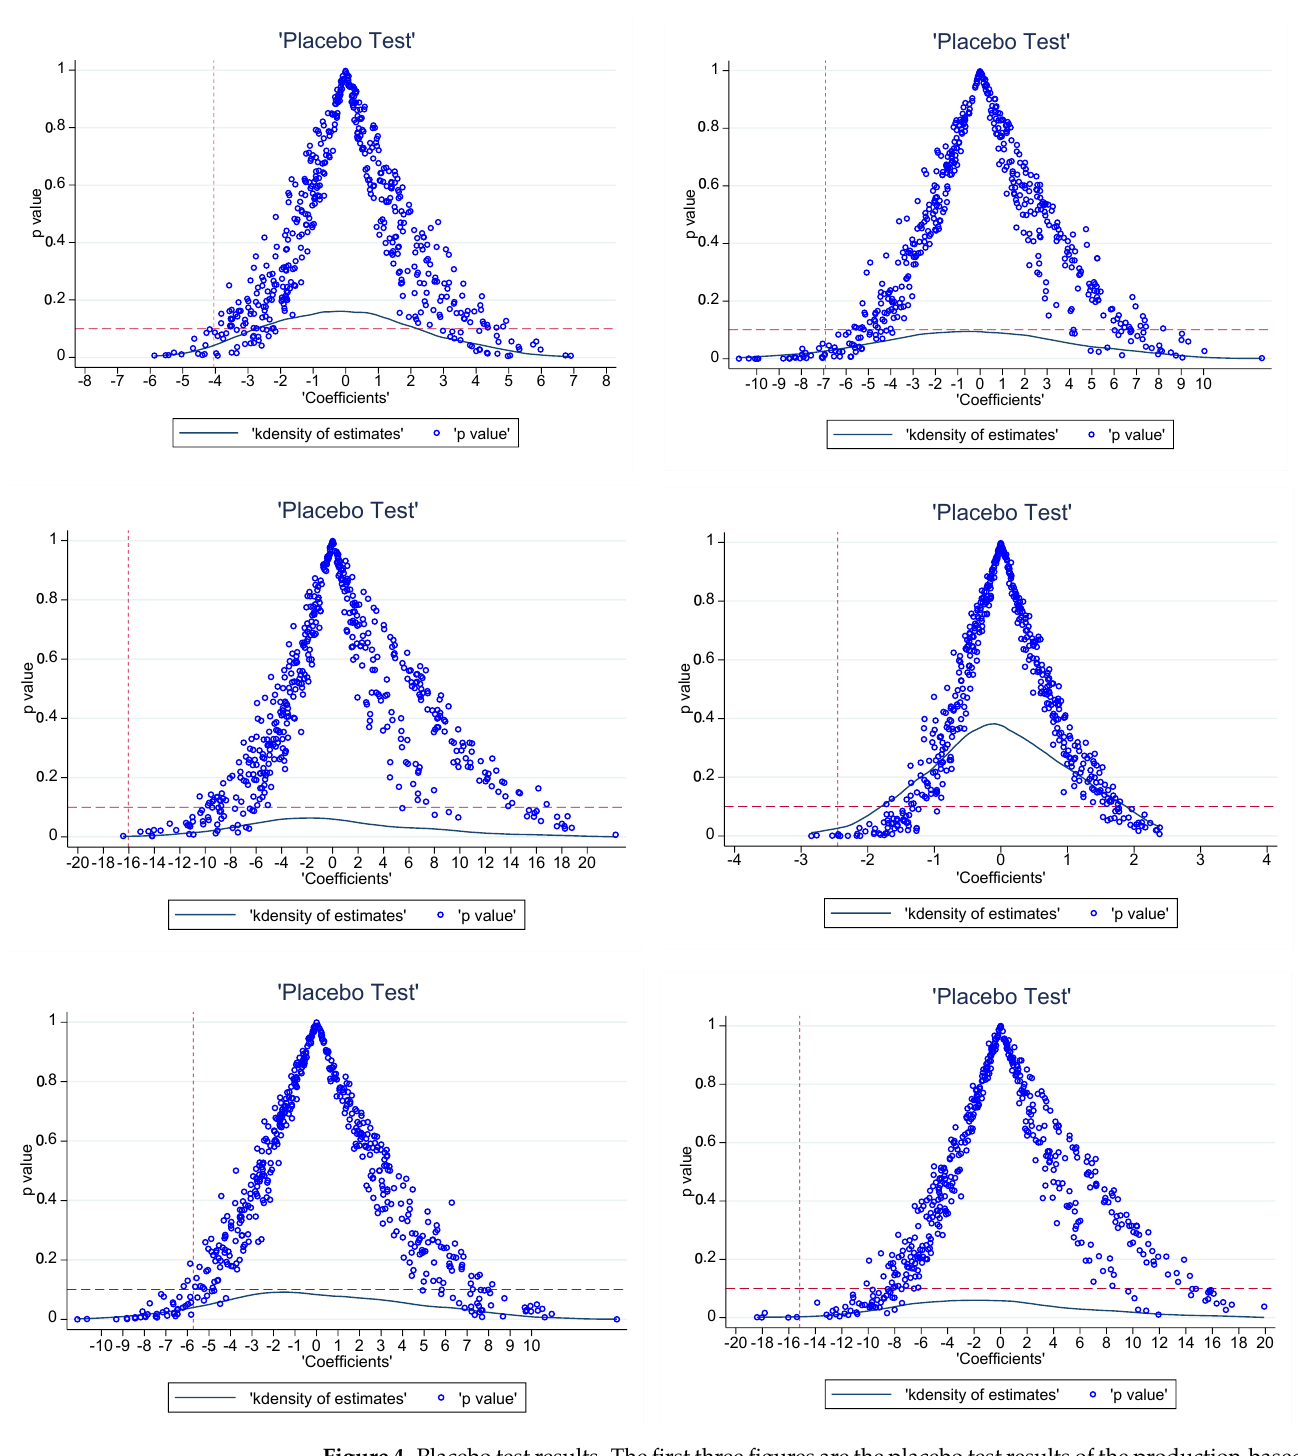
Figure 4. Placebo test results. The first three figures are the placebo test results of the production-based carbon emissions reduction in the chemical, building materials, and metal industries,